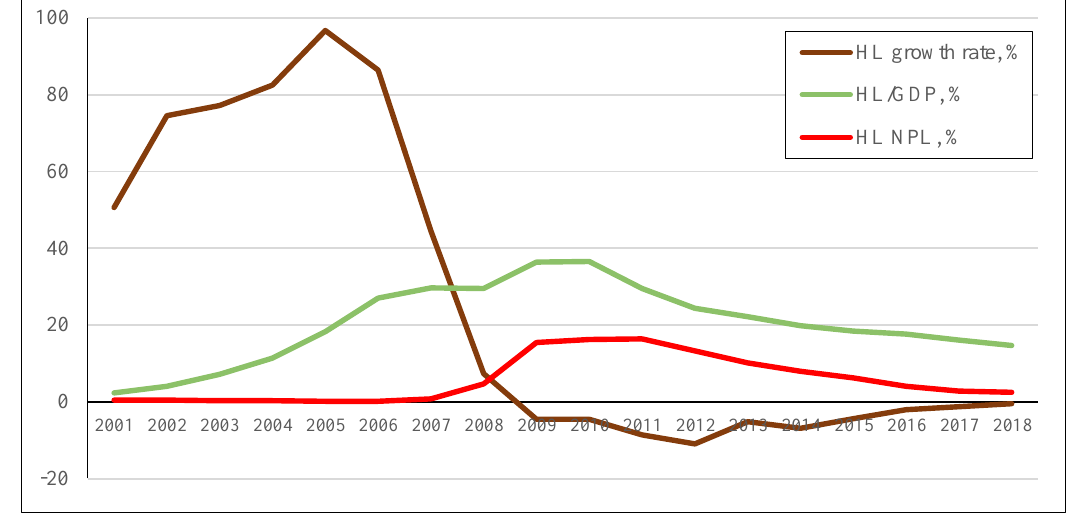
Figure 1. Housing loans growth rate, housing loans proportion to GDP and NPL development in Latvia (FCMC and CSB of Latvia data).